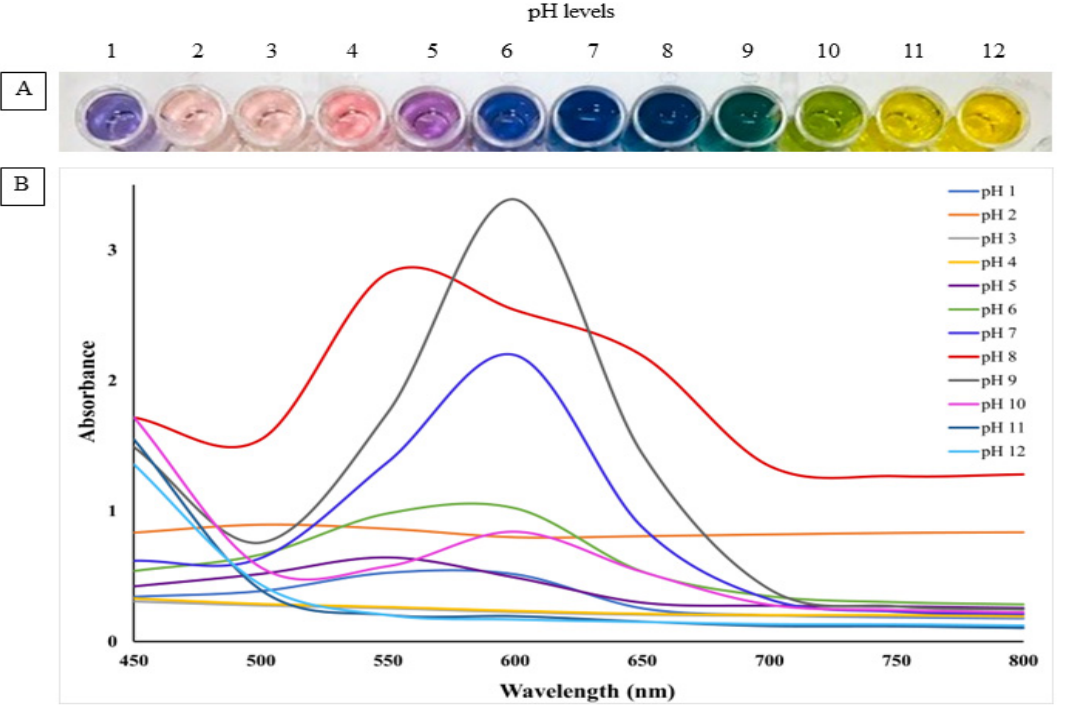
Figure 2. pH sensitivity ( A ) and UV–Vis (G105 UV-VIS, Thermo Scientific Inc., Waltham, NJ, USA) absorption spectra ( B ) of the red cabbage extract at 1–12 levels of pH.